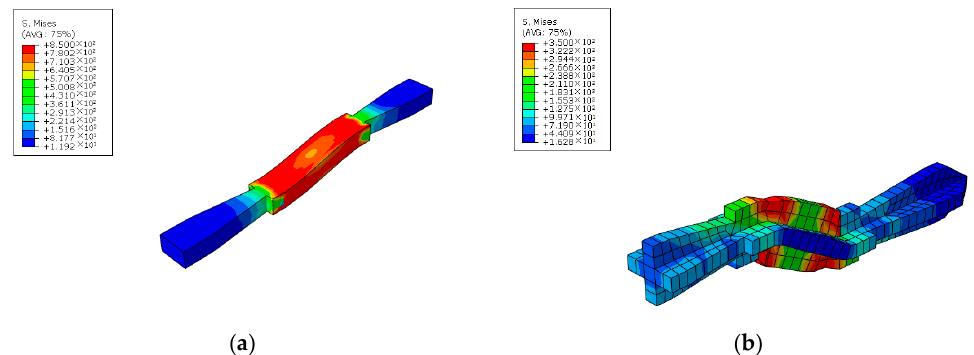
Figure 19. Stress cloud diagrams of connector. ( a ) L1 connector; ( b ) L2 connector. From the load–displacement curve of RP-1 at the coupling point shown in Figure 20,